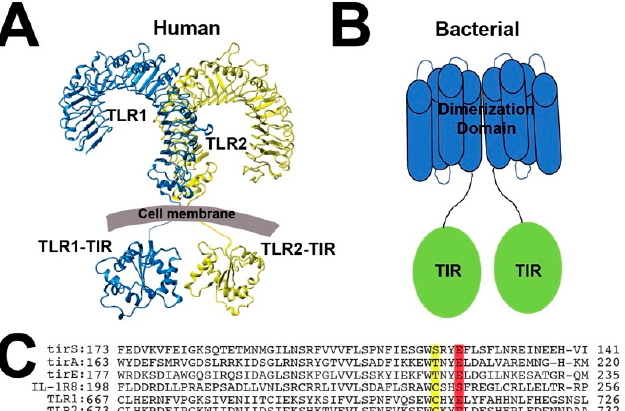
Figure 1. Secondary structure of and sequence comparison of bacterial and mammalian TIR-containing proteins. ( A ) The mammalian TLR1/2 model that includes the crystal structure of the extracellular complex, PDB accession number 2Z7X [15], and the individually crystallized intracellular TIR domains, PDB accession numbers 2FYV and 1FYW [6]. ( B ) Cartoon representation of bacterial TIR-containing proteins that comprise a CC dimerization domain (blue) and TIR domain (green). ( C ) Sequence comparison of the three bacterial TIR-containing proteins (tirS, tirA, and tirE) and three mammalian TIR domains (IL-1R8, TLR1, and TLR2), illustrating the conserved mammalian cysteine (yellow) and bacterial catalytic glutamic acid (red).